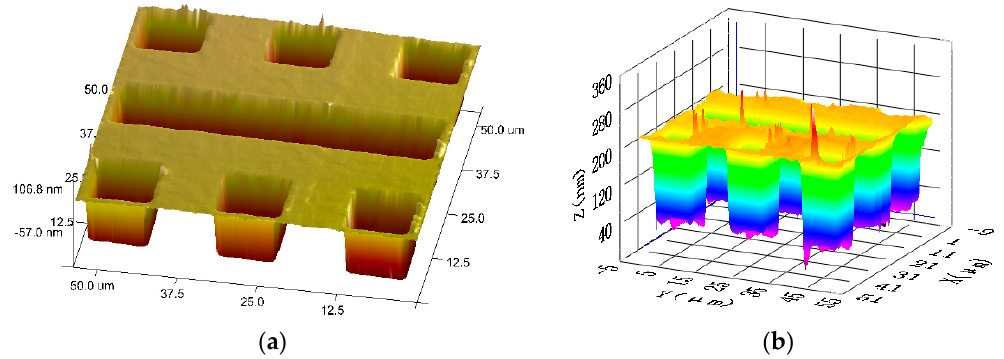
Figure 6. 3D map of Areal Star Pattern. ( a ) 3D map tested by atomic force microscopy (AFM); ( b ) 3D map tested by ICM (DLL Plan Objective numerical aperture (NA) = 0.80).